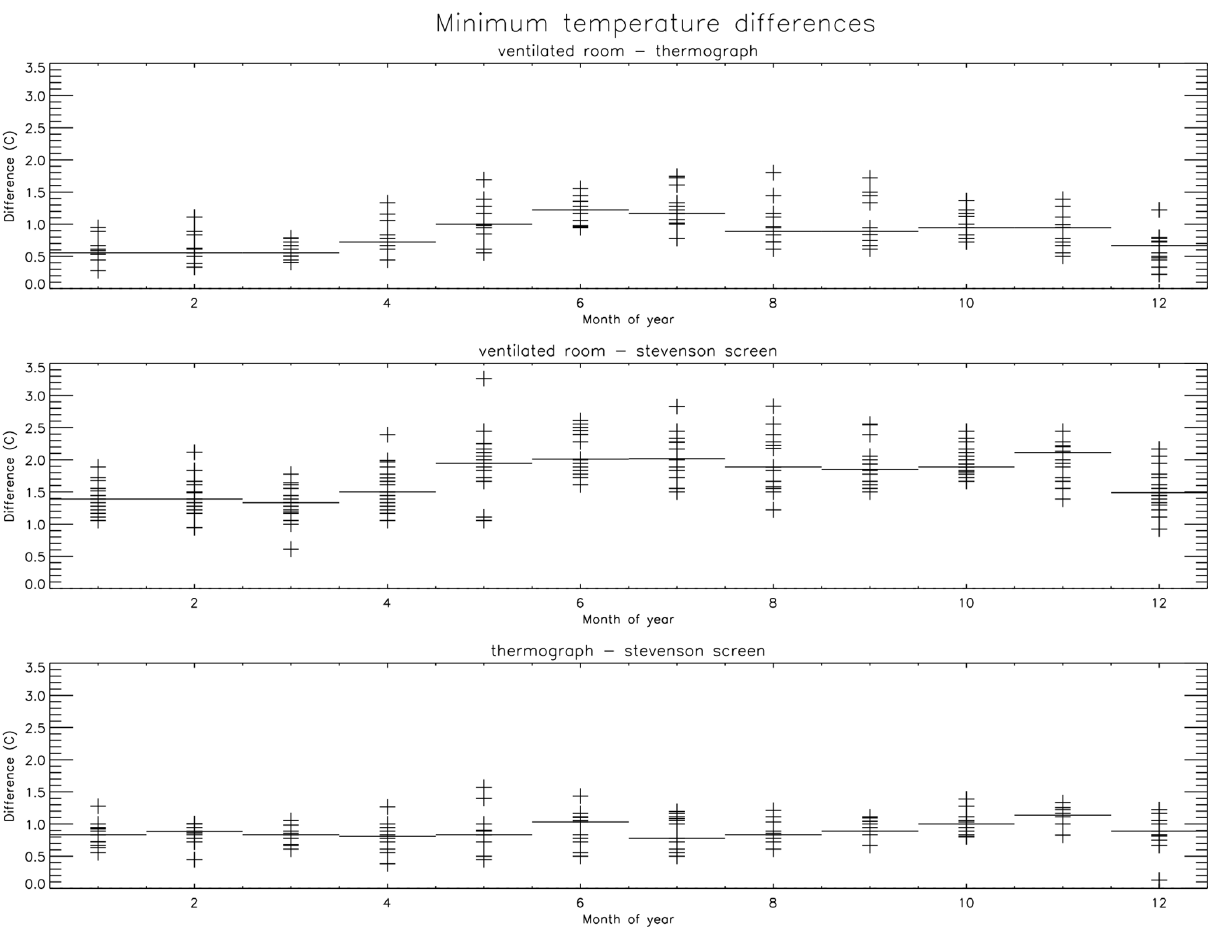
Figure 14. As Fig. 12 but for Tn. Axis ranges are identical between panels but differ from those in Fig. 12.